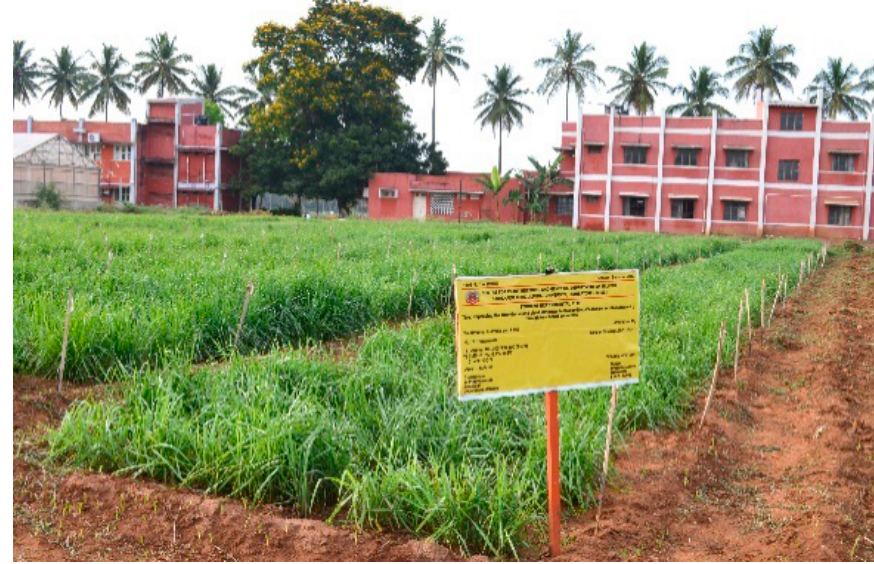
Figure 1. Field view of the M 2 (mutant second) generation.